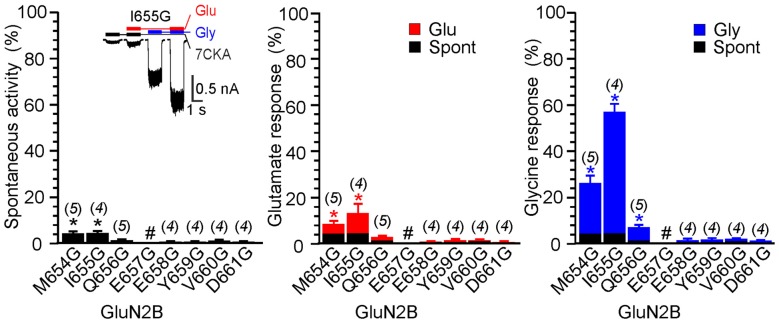
The effect of glycine mutagenesis of the GluN2B M3-S2 linker. Summary graphs of the mean ± SEM (n) of the relative responses–RISpont (black columns), RIGlu (red columns) and RIGly (blue columns; see Equation 1–3)–in receptors with a single residue mutated to glycine in the GluN2B linker. Inset, representative current responses of GluN1/GluN2B(I655G). Application of ECS containing 7CKA (10 μM) with no added Mg2+, glutamate, or glycine is indicated by a black bar (7CKA); application of 1 mM glutamate and 7CKA (10 μM) with no added Mg2+ or glycine is indicated by a red bar (Glu); application of 0.1 mM glycine with no added Mg2+ or glutamate is indicated by a blue bar (Gly). In between the applications of Mg2+-free ECS the cells were bathed in ECS containing 2 mM Mg2+. Differences in the relative responses determined for WT and mutated receptors were statistically significant; one-way ANOVA (P < 0.001); followed by multiple comparisons of the relative responses of mutated receptors vs. WT (RISpont 0.44 ± 0.06 (n = 24); RIGlu 0.63 ± 0.30 (n = 24); RIGly 1.1 ± 0.2 (n = 24)); Dunnett’s test; *P < 0.050. #Indicates a nonresponding mutation.